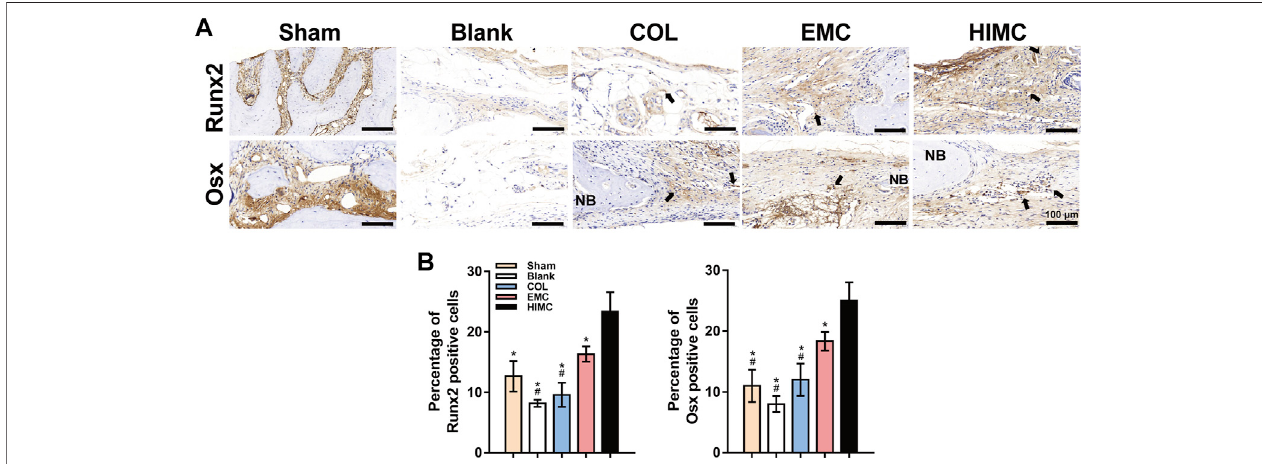
FIGURE6| RepresentativeimagesofIHCstainingforosteogenesismarkersinthedefectregionofdifferentgroupsat2 weekspost-surgery.Positivelystainedcells are indicated by arrows. (A) Runx2 and Osx expression in defect tissues. (B) Semi-quanti fi cation of the positive cells. Data are expressed as mean ± SD. Scale bar,